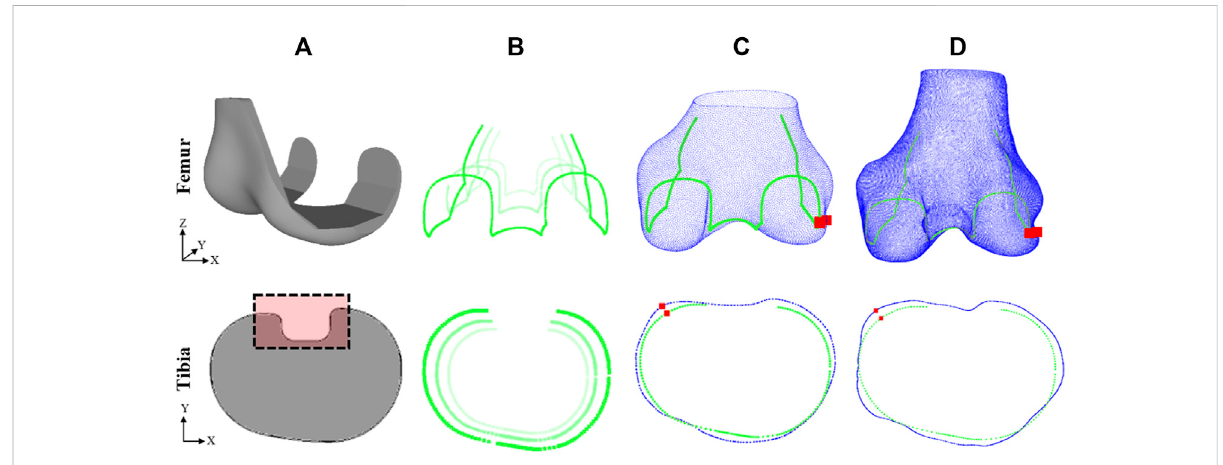
FIGURE 3 Method for evaluating fi t of implant model on subject ground truth anatomy (top row – femur, bottom row – tibia): (A) Generic implant componentdesigns, (B) edgesofscaledcomponents, (C) scaledcomponents fi ttedtosubject3Dmodelpredictions, (D) scaledcomponents fi ttedto subject ground truth anatomy. Dashed box in (A) shows detail not included in fi t analysis. Red squares in (C) and (D) show the location of the maximum OUH.